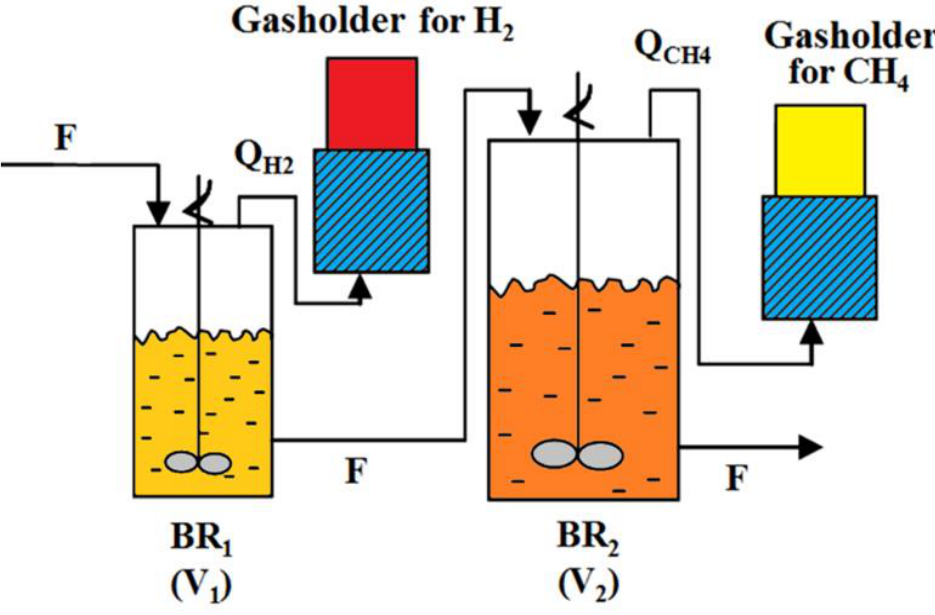
Figure 2. AD process with production of hydrogen and methane.